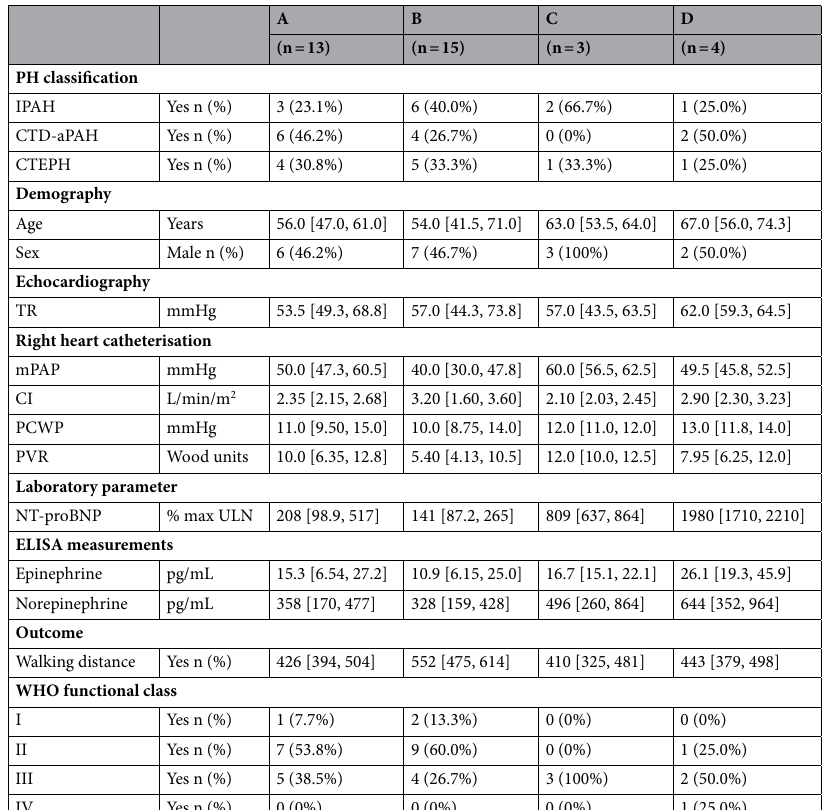
Table 2. Clinical characteristics and catecholamine measurements of PH phenotypes A–D. Medians (IQR) or n (%) are reported. CI, cardiac index; CTD-aPAH, connective tissue disease associated PAH; CTEPH, chronic thromboembolic pulmonary hypertension; IPAH, idiopathic pulmonary arterial hypertension; mPAP, mean pulmonary arterial pressure; NT-proBNP, N-terminal ( NT )-pro brain natriuretic peptide (BNP) ; PCWP, pulmonary capillary wedge pressure; PVR, pulmonary vascular resistance; TR, tricuspid regurgitation; ULN: upper limit of